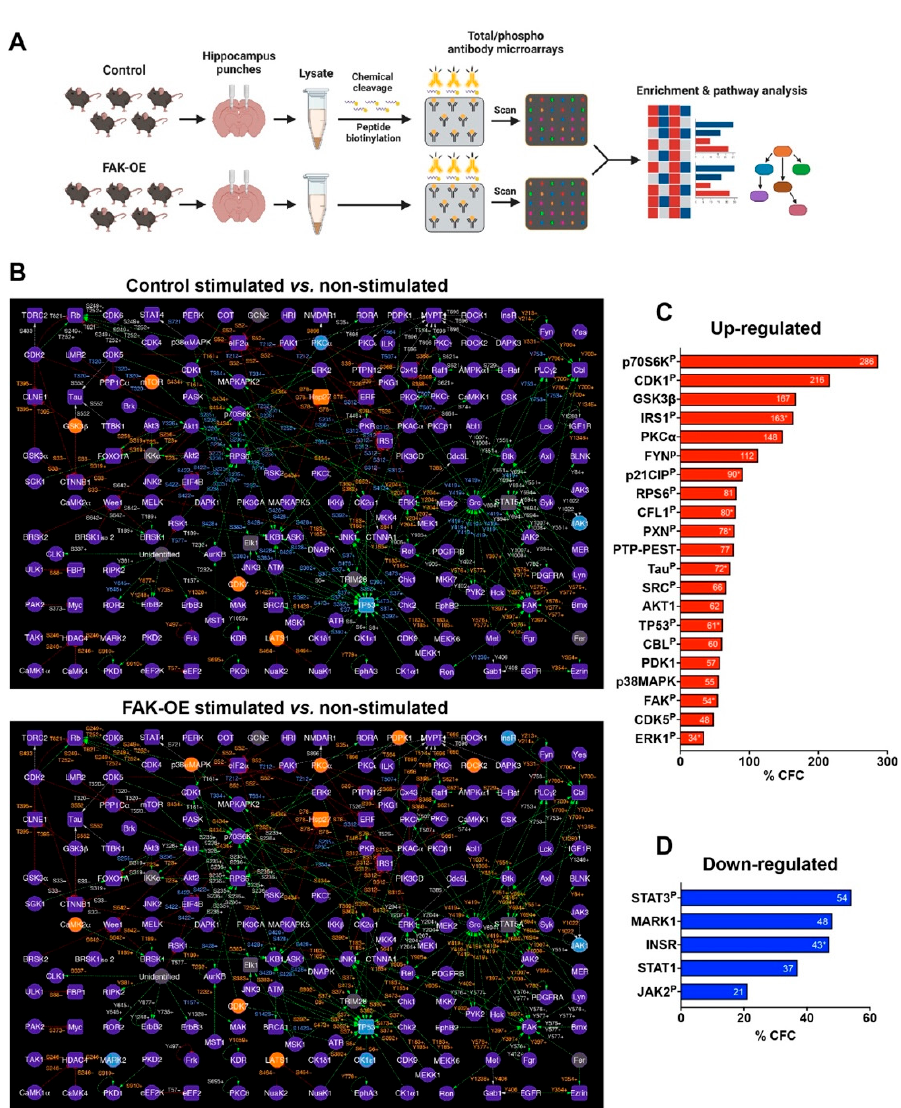
Figure 6. Interaction network maps of hippocampal proteins from control and FAK-OE mice following memory and learning stimulation. ( A ) Diagram of the antibody microarray assay. ( B ) Interaction network maps of hippocampus proteins from control (top map) and FAK-OE (bottom map) mice following learning and memory paradigms, normalized to corresponding non-stimulated mice. Protein nodes which appear in purple represent proteins which had no change in expression. Orange nodes represent proteins with expression increased in 45% CFC or greater. Blue nodes represent proteins with expression decreased in 45% CFC or lower. Grey nodes represent proteins in which expression was not tracked with antibodies on the microarrays. Green lines (edges) represent interactions where a protein kinase phosphorylates a target substrate protein and activates it. Red lines represent interactions where a protein kinase phosphorylates a target substrate protein and inactivates it. Grey lines represent interactions where the effects of protein kinase mediated phosphorylation on the target protein are unknown. Orange color of phosphosite text near connecting edges represent an increase in the phosphorylation of the substrate protein by 45% CFC or greater following stimulation. Blue color of phosphosite text near connecting edges represent a decrease in phosphorylation of a target substrate by 45% CFC or lower following stimulation. Changes in phosphorylation that were less than 45% CFC are depicted in grey text. Protein kinases and protein phosphatases appear as circular nodes. Non-kinase and non-phosphatase proteins appear as square shaped nodes. Kinase-substrate interaction connections are based on in vitro experimental data from the scientific